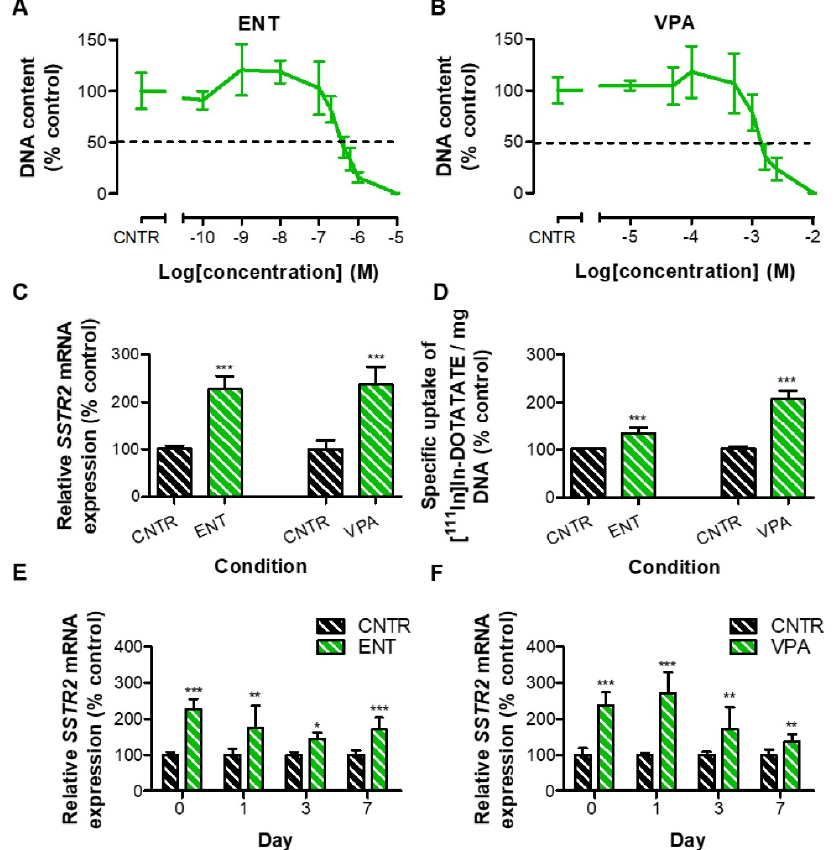
Figure 4. To examine the effect of HDACis in the GOT1 cell line, a dose–response curve was prepared for ENT ( A ) and for ENT ( A ) and VPA ( B ). After a seven-day treatment with the IC 50 dose, the increase in ( C ) SSTR2 VPA ( B ). After a seven ‐ day treatment with the IC 50 dose, the increase in ( C ) SSTR2 mRNA levels and ( D ) total uptake of mRNA levels and ( D ) total uptake of radiolabeled SSAs were examined. ( E , F ) Reversibility radiolabeled SSAs were examined. ( E – F ) Reversibility profiles after HDACi withdrawal were evaluated by RT ‐ qPCR di ‐ rectly after treatment (D0), and one (D1), three (D3), and seven days (D7) after HDACi withdrawal. Results in C ‐ F were normalized to vehicle ‐ treated cells. * p < 0.05, ** p < 0.01, *** p < 0.001.